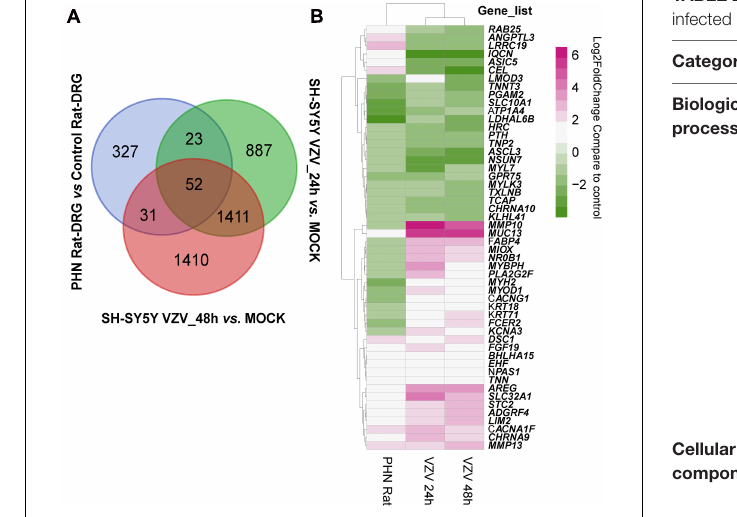
FIGURE 6 | Analysis of the identical DEGs in VZV-infected SH-SY5Y cells and VZV-induced PHN rat DRG. (A) The Draw Venn Diagram online tool was used to obtain the identical DEGs in VZV-infected SH-SY5Y cells and VZV-induced PHN rat DRG. (B) The Pheatmap package was used to map the gene expression heatmap of the identical DEGs in the DRG of VZV-induced PHN rats and SH-SY5Y cells infected by VZV.